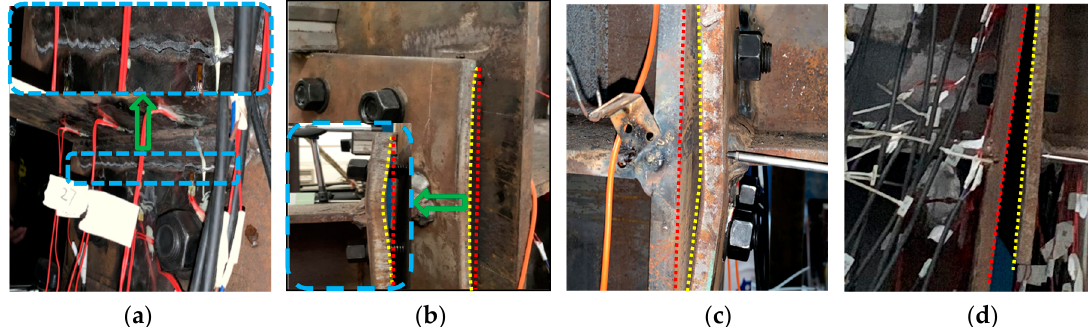
Figure 10. Local deformation of specimens: ( a ) Weld fracture; ( b ) Upper flange end-plate bending; ( c ) Lower flange end-plate bending; ( d ) Separation of end-plate and column web.